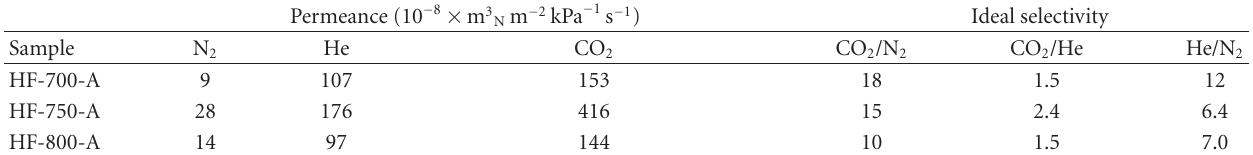
Table 3: E ff ect of end temperature on the permeance of carbon hollow fibers.